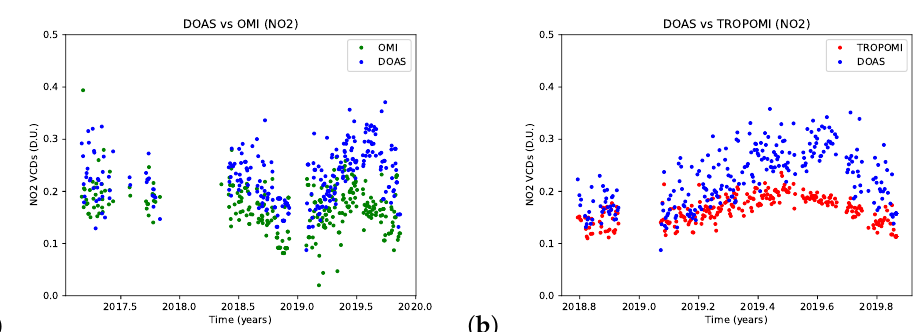
Figure 13. NO 2 VCDs measured by GASCOD/NG4 (blue dots in both panels), OMI (green line in the panel ( a )) and TROPOMI (red line in the panel ( b )) over the ECO observatory. DOAS measurements are time averages in a 3-h time bin around satellite overpass, and satellite data are the averages of all the coincidences within a 20 km radius.